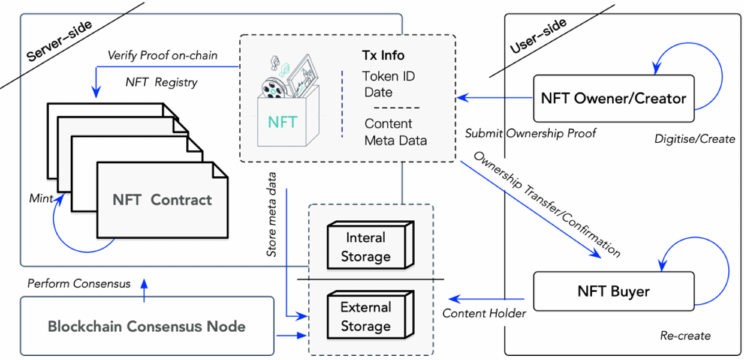
Figure 1. “Model of NFT Systems” (taken from Wang, Qin, et al. “Non-fungible token (NFT): Overview, evaluation, opportunities and